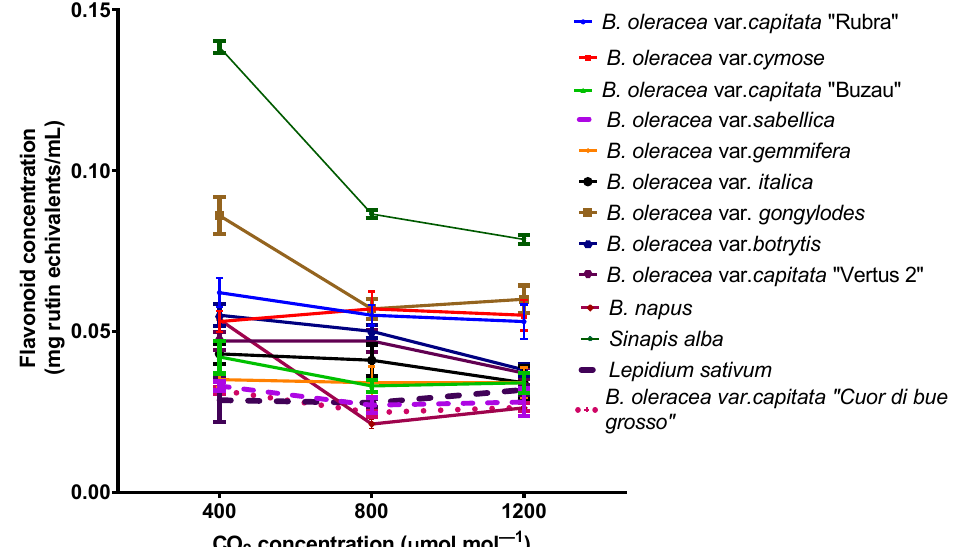
Figure 5. Total flavonoids content from Brassicaceae plants grown at three carbon dioxide concentra- tions. The values are averages of three independent measurements. Stomatal characteristics did not differ between plants from different treatment groups (Figure 6). The stomata length among the three treatments are 26.37 ± 3.09 µm for 400 ppmv CO 2 , 24.35 ± 1.84 µm for 800 ppmv CO 2 , and 26.73 ± 1.71 µm for 1200 ppmv CO 2 , which are not statistically different among treatments (one way ANOVA followed by Tukey’s multiple comparisons post hoc test, p = 0.7356).